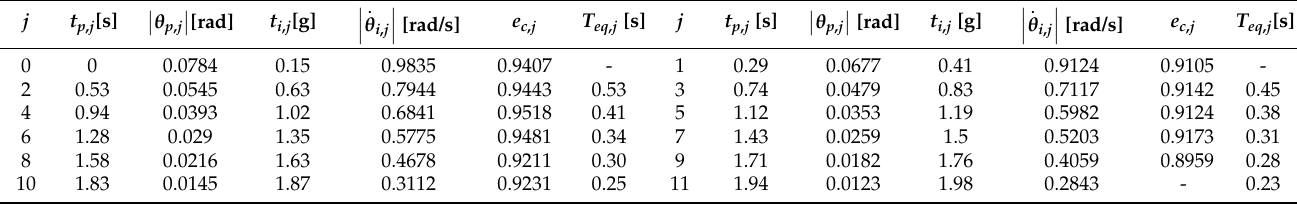
Table 6. Summary of the results of the free oscillation test block type